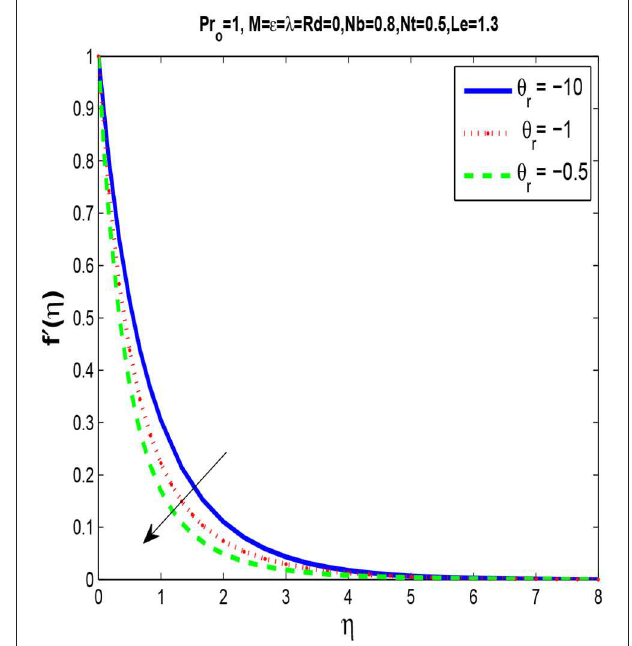
FIGURE 2 | Velocity profile f ′ ( η ) for different M ( For Case B). FIGURE 3 | Velocity profile f ′ ( η ) for different θ r ( For Case B).